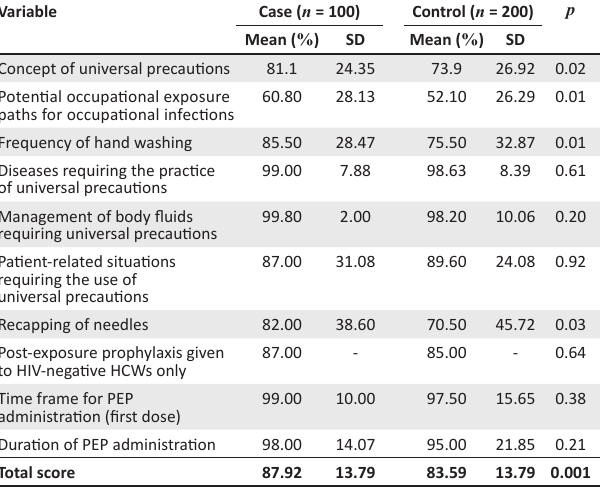
TABLE 2: Comparison of knowledge scores about universal precautions and post-exposure prophylaxis among health care workers (cases and controls) ( N = 300).